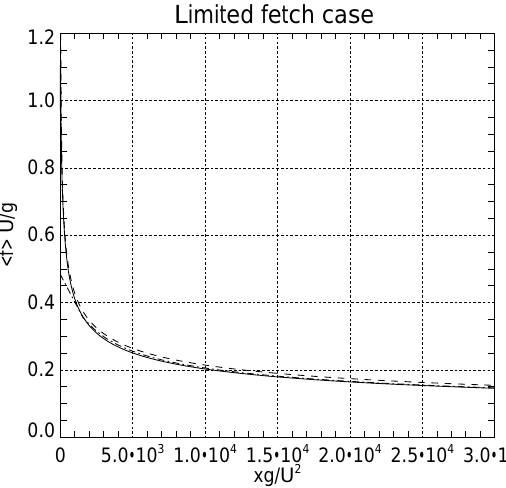
Figure 12. Dimensionless energy Eg 2 /U 4 vs. dimensionless fetch xg/U 2 for the fetch limited case: wind speed U = 10ms − 1 – solid line; wind speed U = 5ms − 1 – dash-dotted line. Self-similar solu- tion with the empirical coefficient in front of it: 2 . 9 × 10 − 7 xg/U 2 – dashed line.